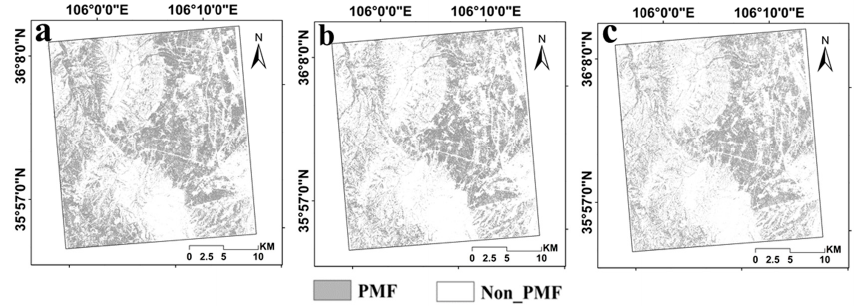
Figure 9. The spatial distribution of PMF in Guyuan (( a ) result from RF using backscattering intensity of four polarizations, ( b ) result from RF using all features, ( c ) result from SVM using all